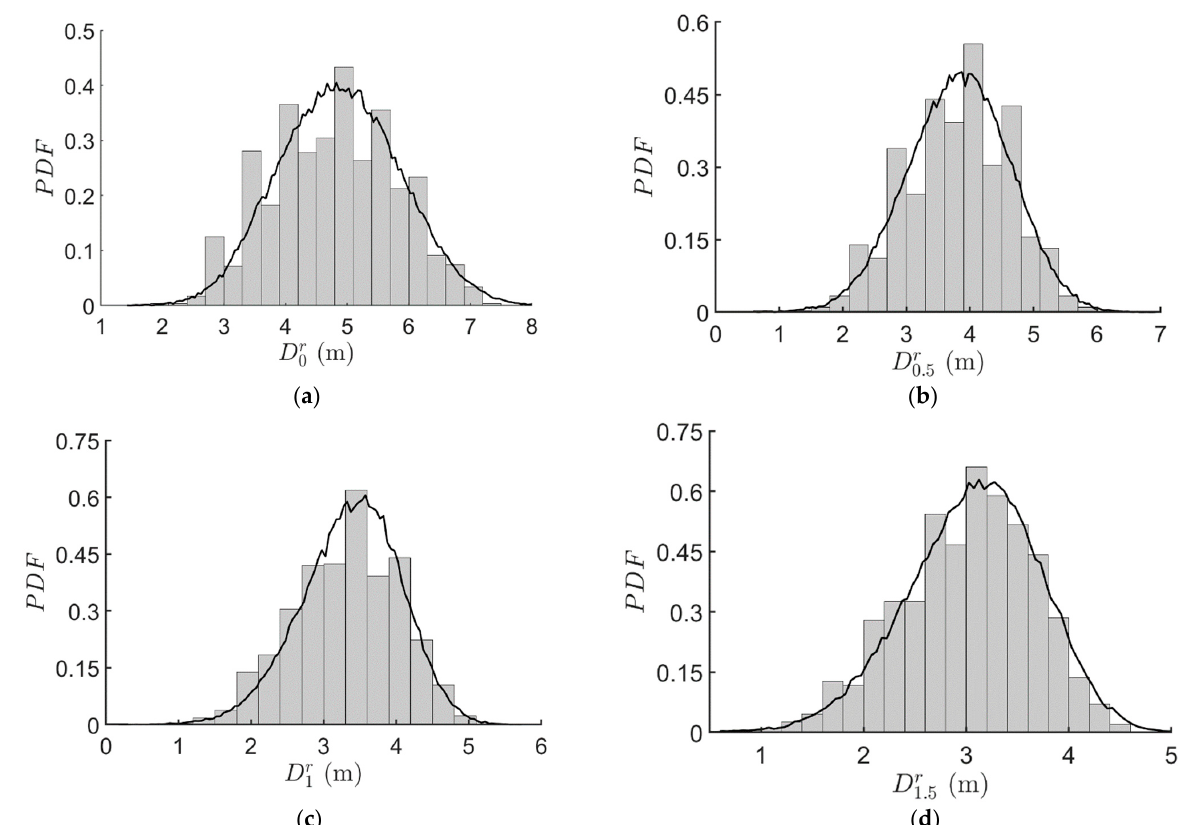
Figure 22. The estimated probability density function of runout (histogram: 1000 samples with brute-force simulations; solid line: 10 5 samples, evaluated with the machine-learning model): ( a ) PDF of 𝐷 (cid:2868)(cid:3045) ; ( b ) PDF of 𝐷 (cid:2868).(cid:2873)(cid:3045) ; ( c ) PDF of 𝐷 (cid:2869)(cid:3045) ; ( d ) PDF of 𝐷 (cid:2869).(cid:2873)(cid:3045) .